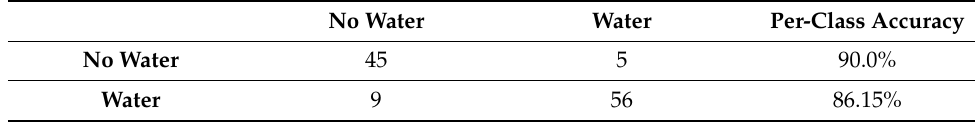
Table 2. Confusion matrix for the proposed CNN+LSTM model.